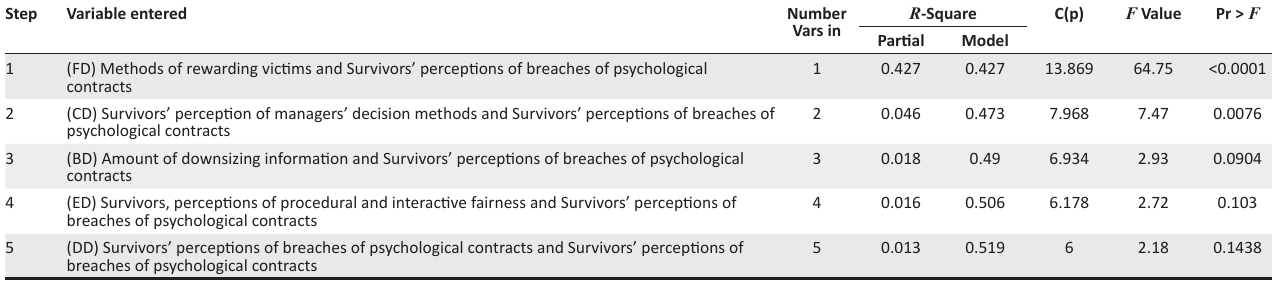
TABLE 7: Regression of organisational citizenship behaviour (summary of forward-selection procedure). Step Variable entered